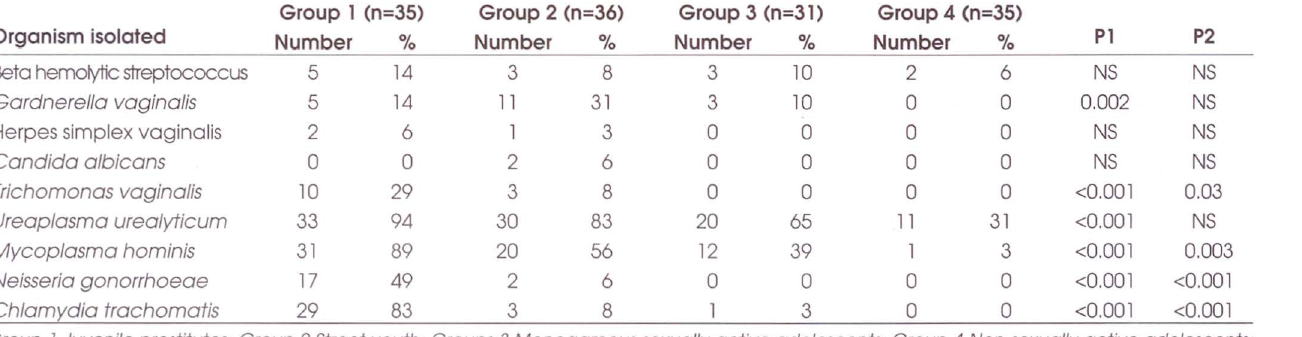
Sexually transmitted diseases in adolescents: Relationships between pathogens and sexual